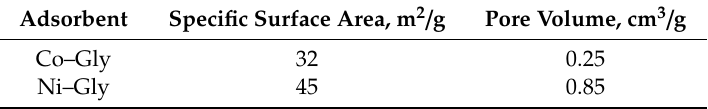
Table 1. Specific surface area and pore volume of the synthesized CNs.